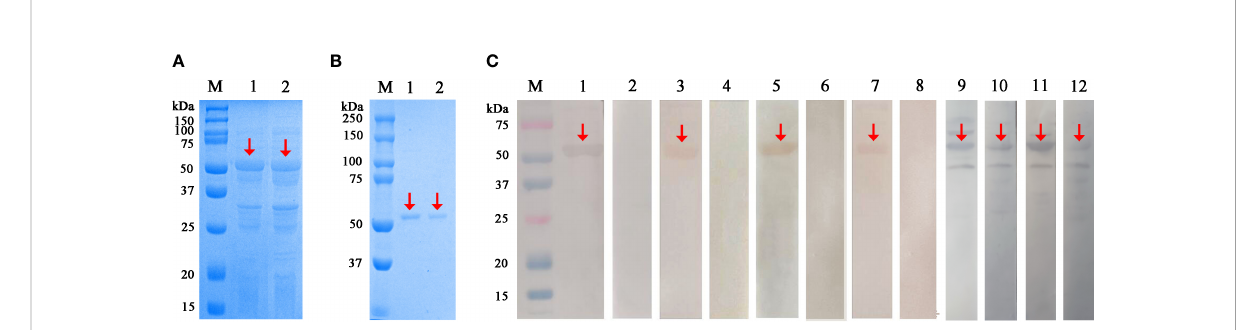
FIGURE 3 Expression, puri fi cation and western blotting analysis of the rSsAKs. (A) rSsAKs expressed in E. coli BL21 (DE3) after induction. M: Protein molecular weight marker, lane 1: rSsAK-1; lane 2: rSsAK-2. (B) Puri fi ed rSsAKs. M: Protein molecular weight marker, lane 1: rSsAK-1; lane 2: rSsAK-2. (C) Western blotting analysis of the rSsAKs. M: Protein molecular weight marker, lanes 1-2: puri fi ed rSsAK-1 detected by rat hyperimmune serum and rat negative serum, respectively; lane 3-4: puri fi ed rSsAK-1 detected by serum from rabbits naturally infected with S. scabiei and uninfected rabbits, respectively; lane 5-6: puri fi ed rSsAK-2 detected by rat hyperimmune serum and rat negative serum, respectively; lane 7-8: puri fi ed rSsAK-2 detected by serum from rabbits naturally infected with S. scabiei and uninfected rabbits, respectively; lane 9-10: rSsAK-1from total bacterial extract detected by rat hyperimmune serum and serum from rabbits naturally infected with S. scabiei , respectively; lane 11-12: rSsAK-2from total bacterial extract detected by rat hyperimmune serum and serum from rabbits naturally infected with S. scabiei , respectively. Red arrows indicate the band of interest, i.e., the